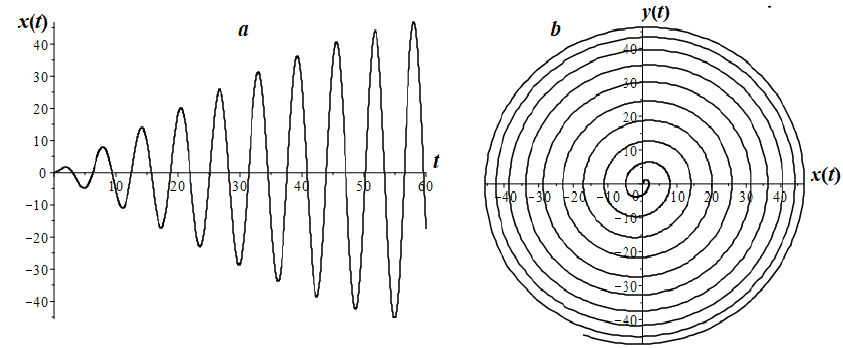
Figure 13. Harmonic oscillator without friction in resonance mode: ( a ) oscillogram; ( b ) phase